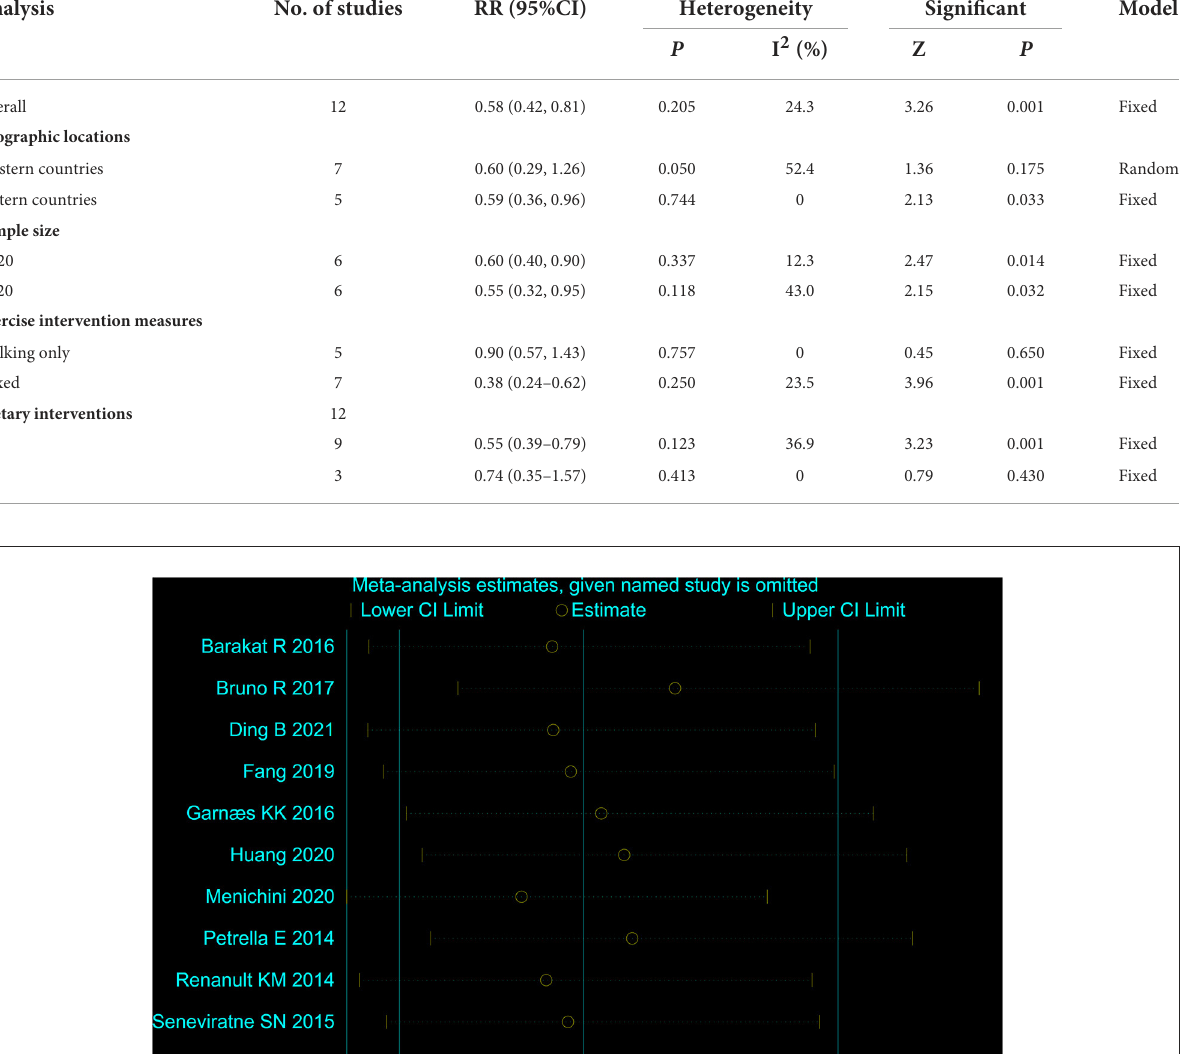
TABLE 2 Summary of pooled RRs with confidence interval (CI) in subgroups analyses.